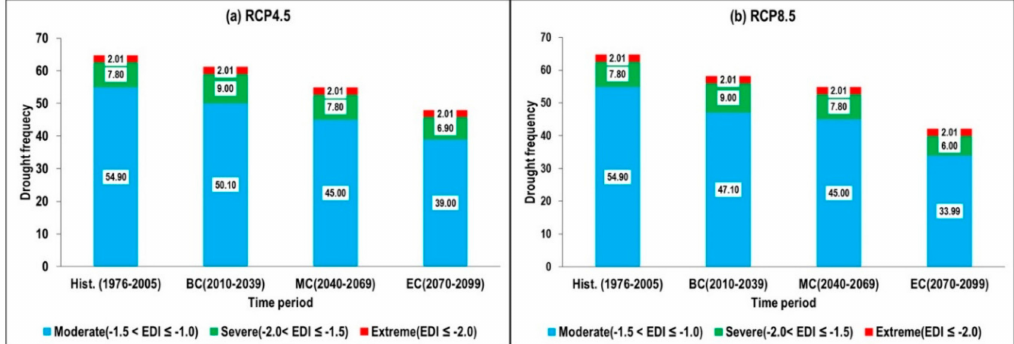
Figure 7. Change in the drought intensity based on a historical period (1976–2005) in regard to extreme, severe, and moderate drought events under the ( a ) RCP4.5 (left) and ( b ) RCP8.5 (right)